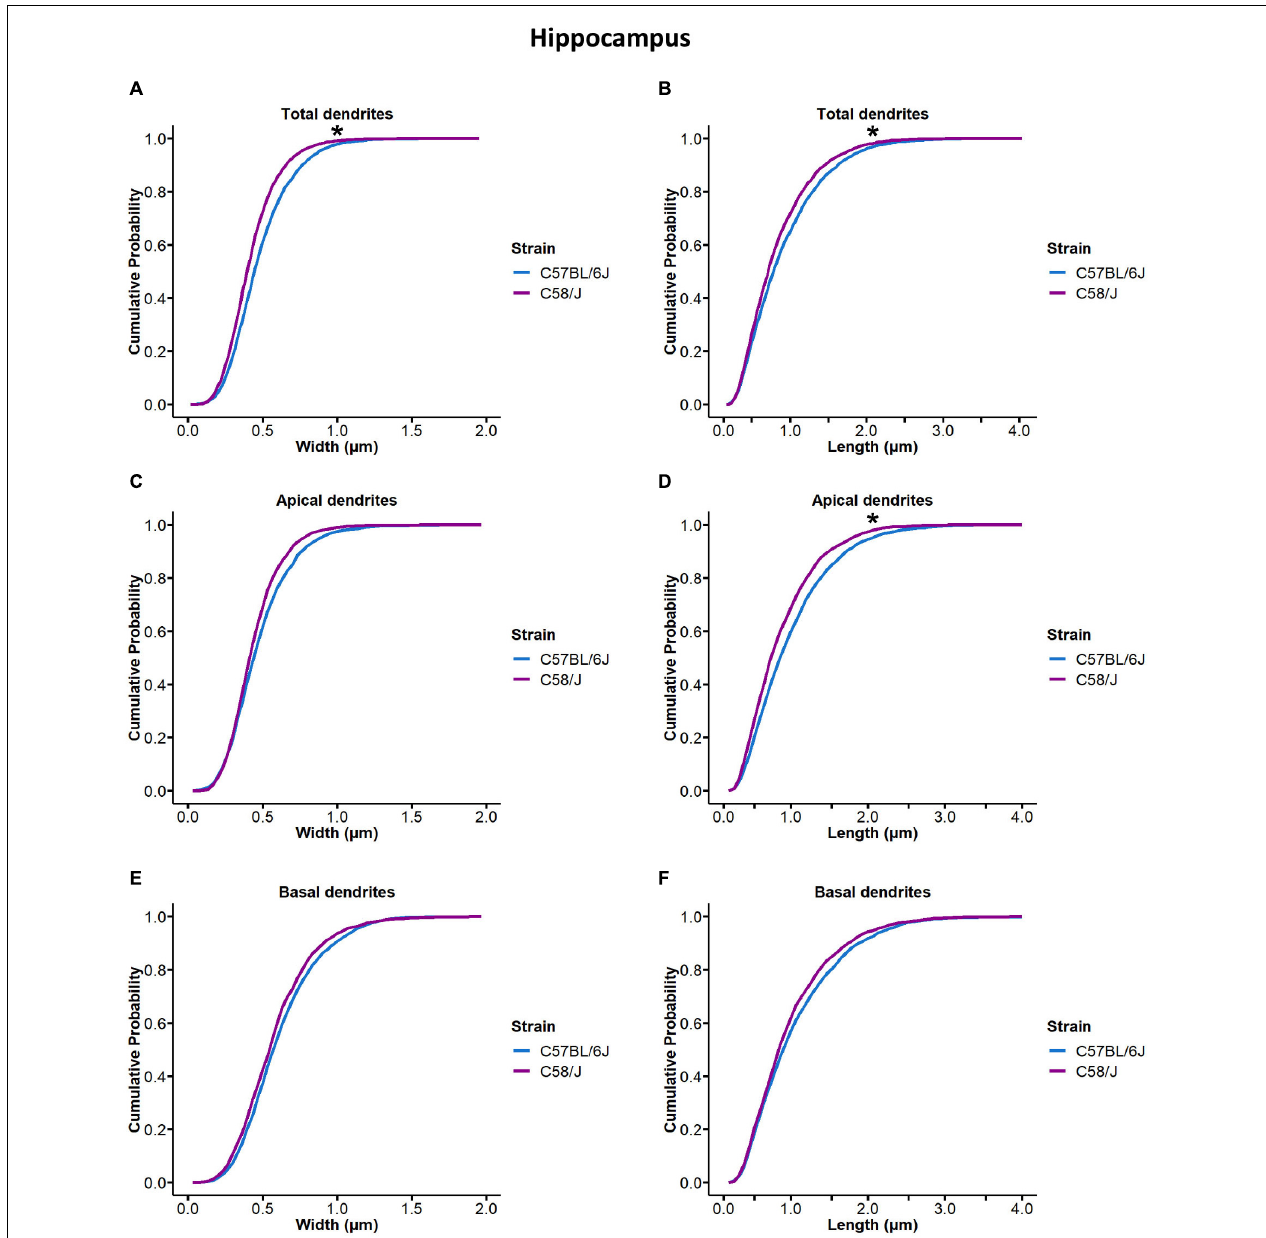
FIGURE 3 | Cumulative probability distribution of spine width and length measurements in the hippocampus of C58/J mice. Cumulative probability distribution ogives of spine width and length measurements in total (A,B) , apical (C,D) , and basal (E,F) dendrites of pyramidal neurons in the hippocampus of C57 BL/6J (neurotypical phenotype) and C58/J (autistic-like phenotype) mice. n = 20 neurons per strain, five neurons per mouse. Kolmogorov–Smirnov test: * p <